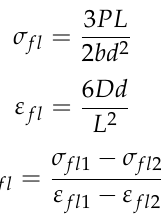
Figure 12. Bottom tensile fracture surface of flexural test specimens. ( a ) Liqcreate Strong-X Compo- site, ( b ) Peopoly Nylon-Like Composite, and ( c ) Peopoly Deft Composite. ( b ) Peopoly Nylon-Like Composite, and ( c ) Peopoly Deft Equation (15) was used for calculating flexural strain, 𝜀 (cid:3033)(cid:3039) , at the outer surface of the